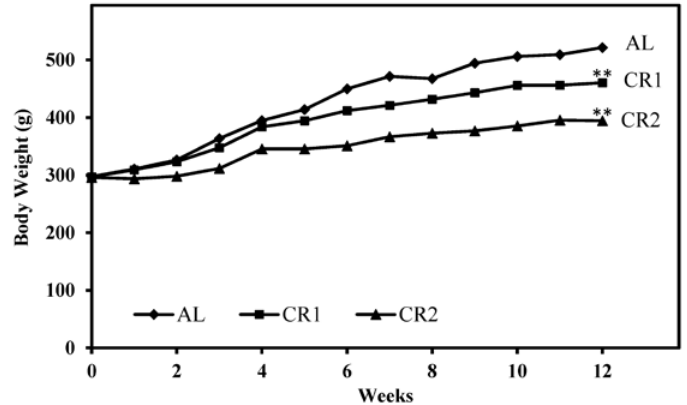
Figure 2. Change of body weights of rats from three groups over the 12-week feeding